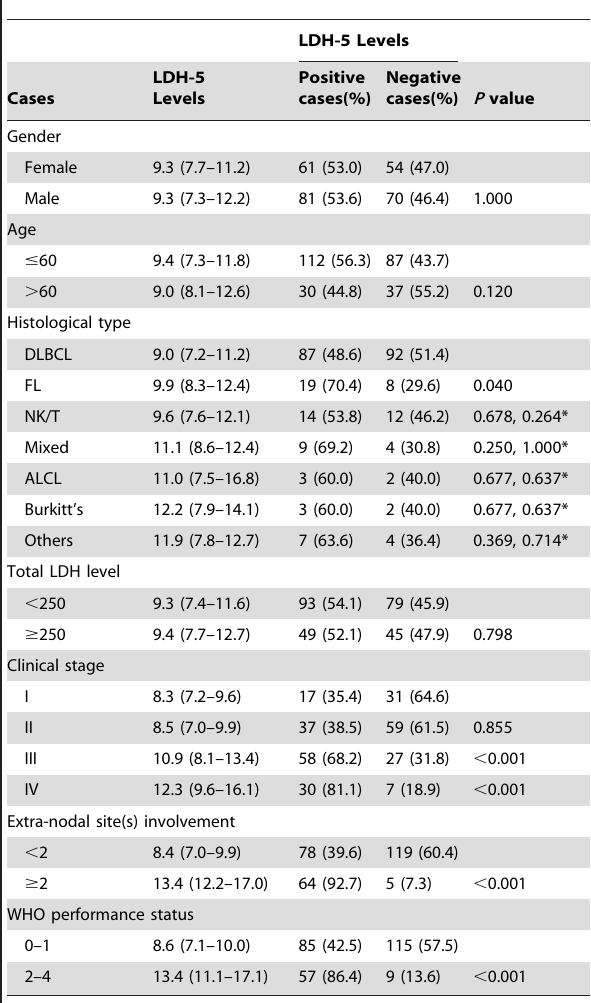
Table 1. LDH-5 levels and the clinicopathological characteristics of 266 patients with